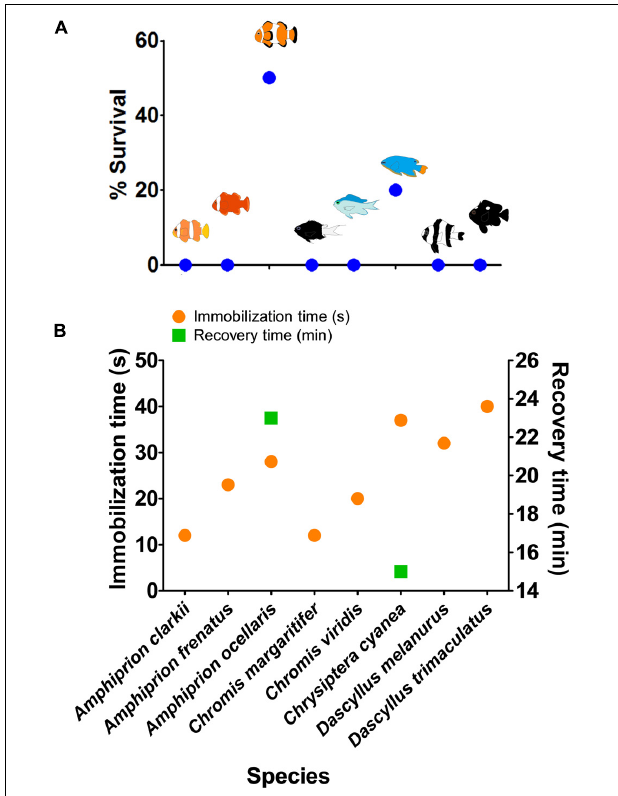
FIGURE 2 | Effects of cyanide pulse exposure (60 s; 50 mg L - 1 of CN - ) on the performance of eight species of family Pomacentridae ( n = 9 or 10 individuals per species), the most traded fish family in the marine aquarium industry. (A) Survival (%) 96 h post-exposure; and (B) immobilization (s) and recovery time (min) recorded for each species. Immobilization time is the time at which the last fish of a species stopped swimming and remained motionless while recovery time is the time at which the last fish of a species returned to normal swimming activity. Fish illustrations by